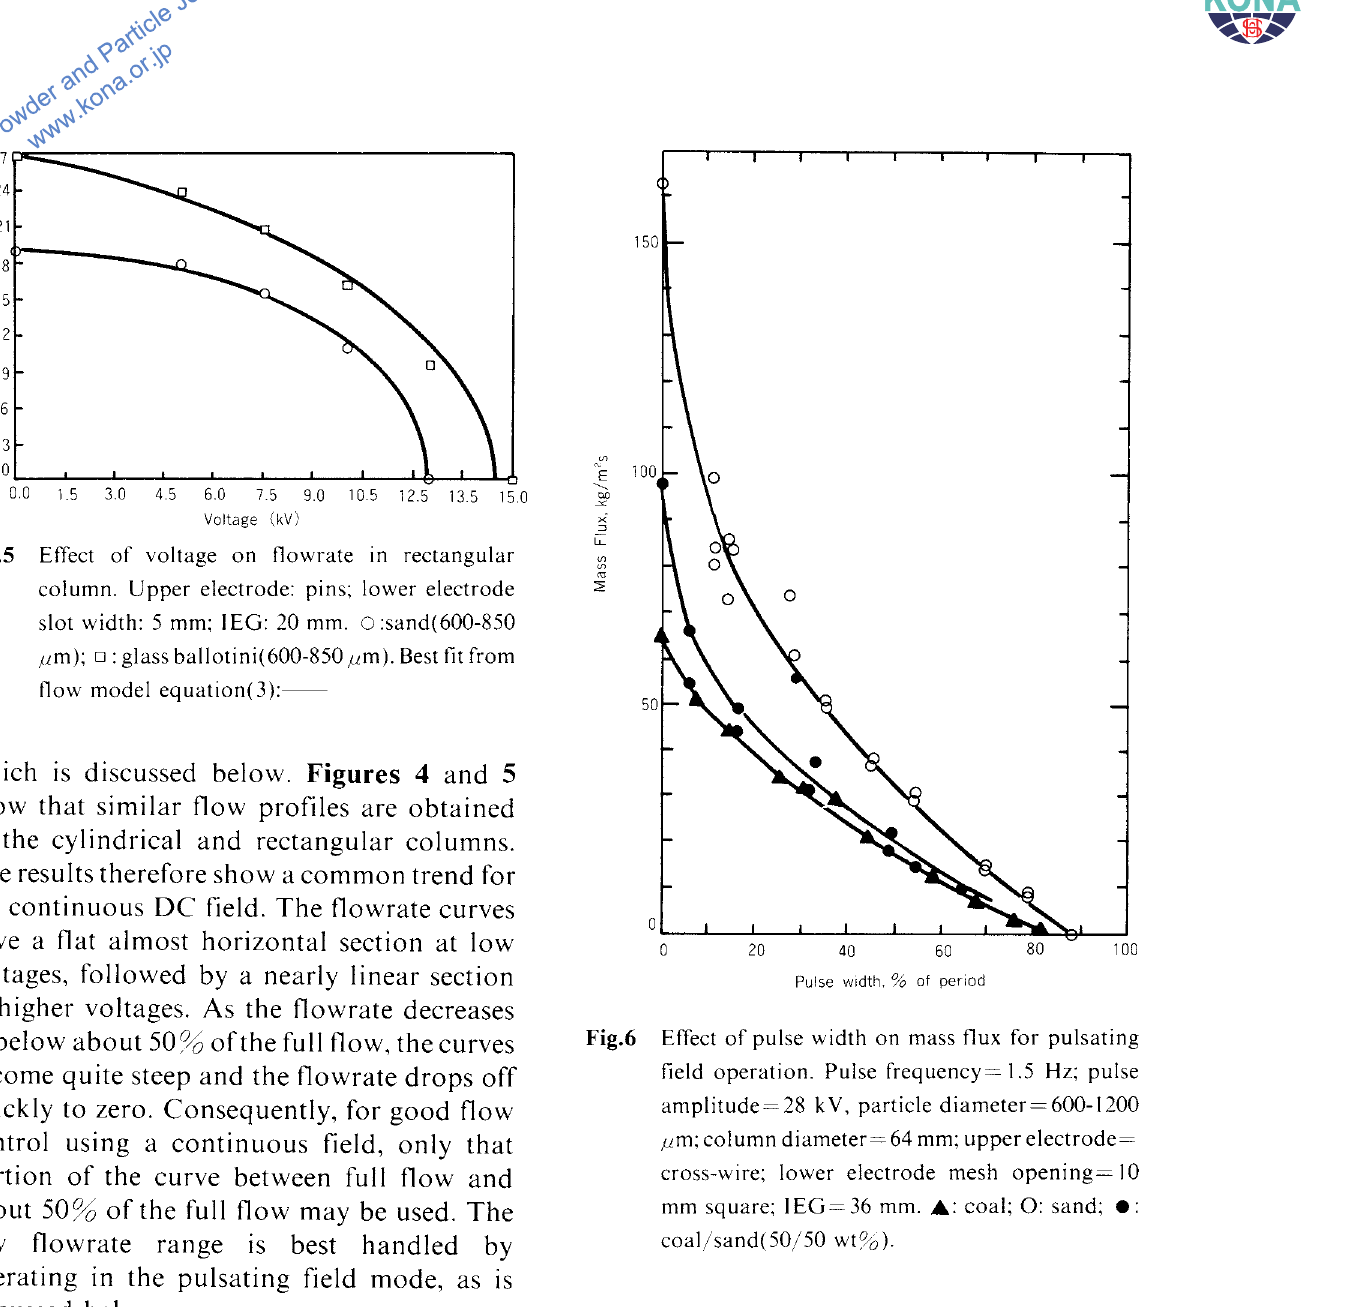
Fig.6 Effect of pulse width on mass flux for pulsating field operation. Pulse frequency= 1.5 Hz; pulse amplitude=28 kV, particle diameter=600-1200 11 m: column diameter=64 mm; upper electrode= cross-wire; lower electrode mesh opening= 10 mm square; I EG = 36 mm. A.: coal; 0: sand; •: coal/sand(50/50